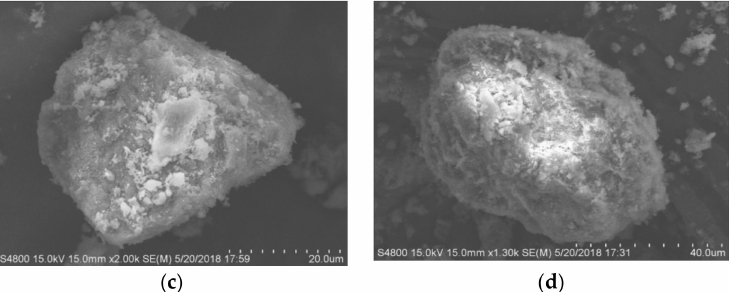
Figure 11. SEM images of ( a ) zeolite, ( b ) diatomite, and ( c , d ) thermally modified green zeolite and diatomite at a ratio of 3:2 and 2:3, respectively.